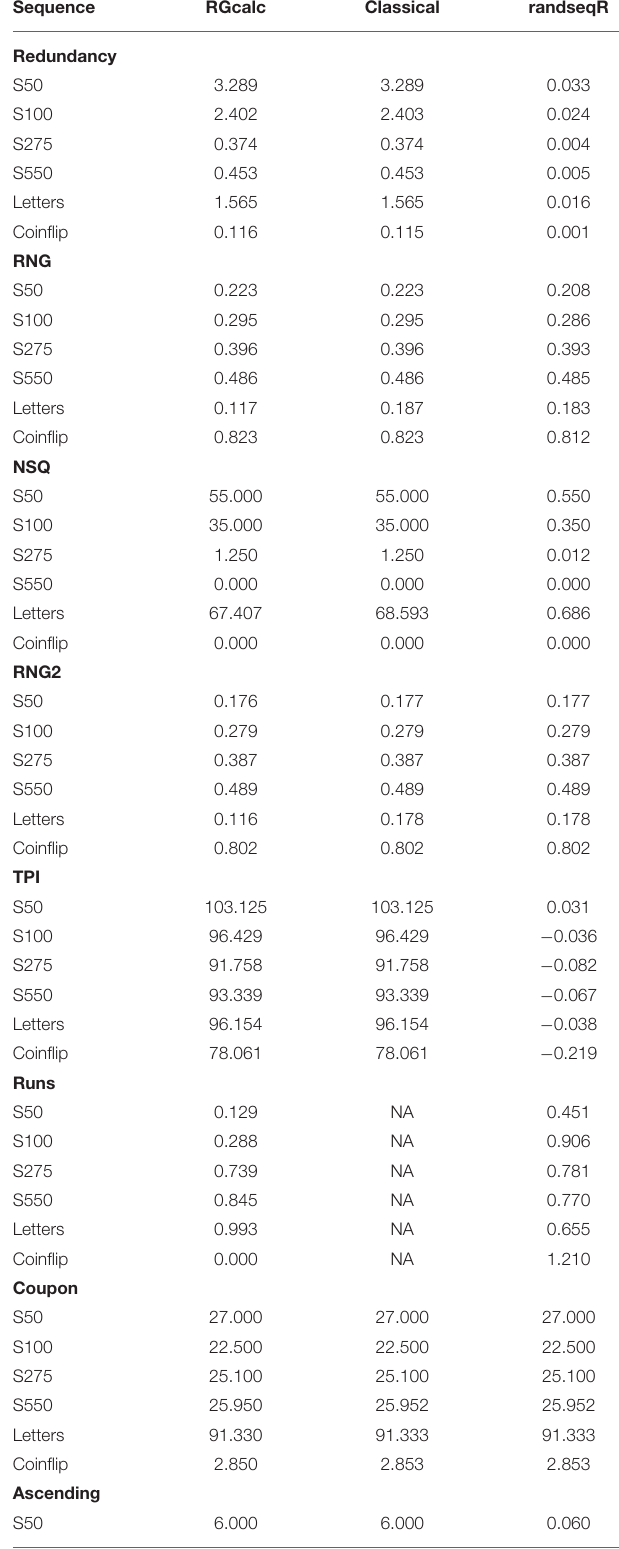
TABLE 1 | RNG output for RGcalc, RandseqR (classical), and RandseqR (default). Sequence RGcalc